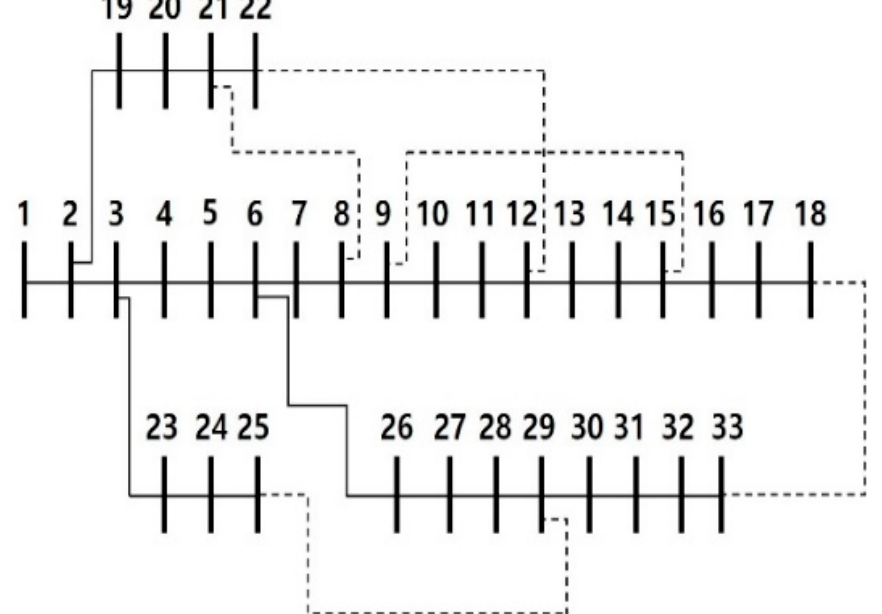
Figure 4. IEEE-33 radial distribution system.